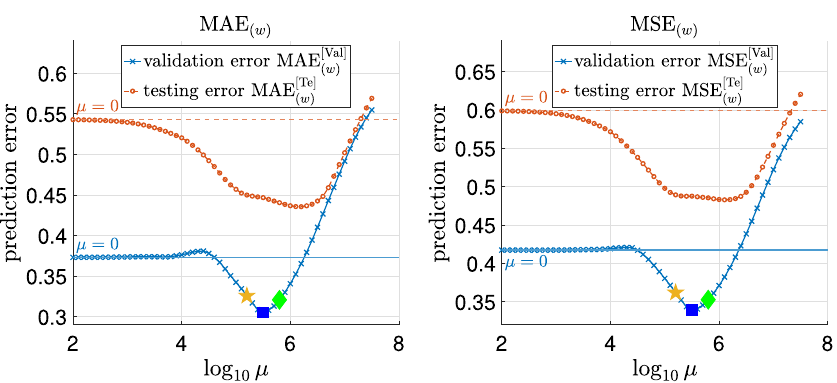
Figure 17. Testing and validation errors on real-world COVID-19 data in Europe. The two plots are similar to those in Fig. 7, with the errors computed on the real-world data in Europe instead of simulated data. Both the MAE and MSE validation errors are minimized at µ = 10 5.5 , which is marked by blue squares in both plots. µ = 10 5.2 and 10 5.8 are chosen by perturbing the minimizer µ = 10 5.5 , have slightly larger validation errors, and are marked with yellow pentagrams and green diamonds in both plots. The construction of training/validation/ testing data is detailed in Sects. A.1.2 and E of Supplementary